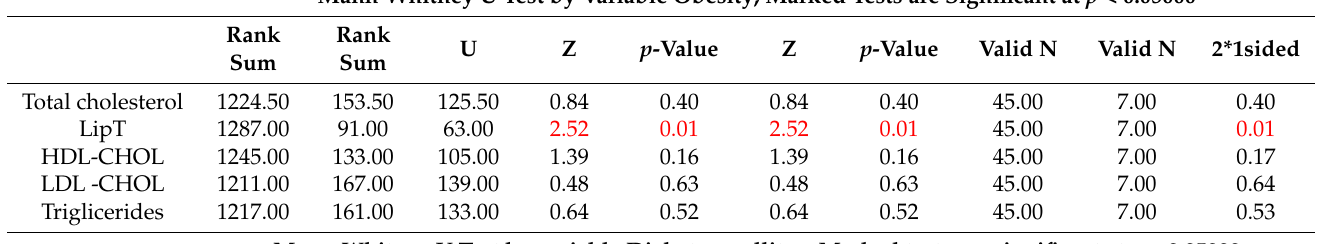
Table 4. Mann–Whitney U test applied for comorbidities and demographic area of COPD